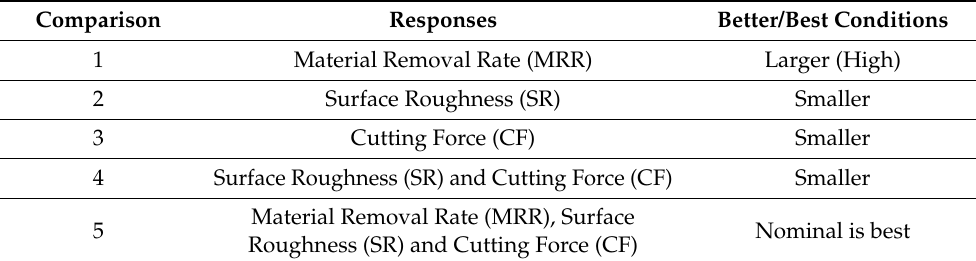
Table 2. Summary of responses and its best conditions.